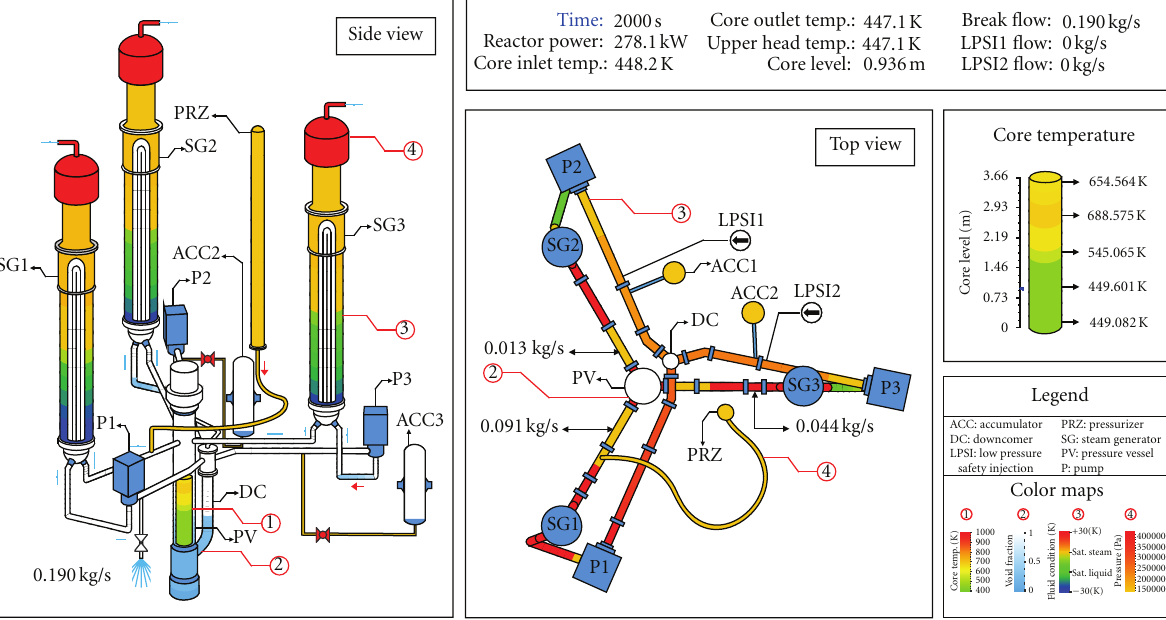
Figure 22: Animation mask for RELAP5 at time t = 2000 s (core